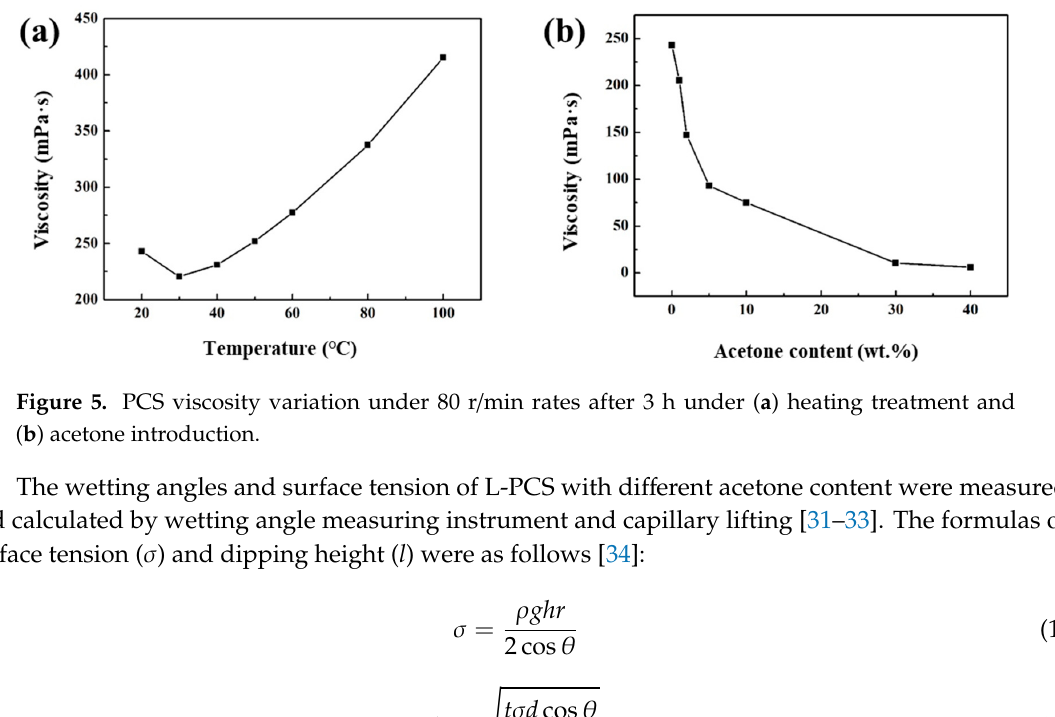
Figure 4. The variation in viscosity with different acetone content of liquid polycarbosilane (L-PCS) solutions.